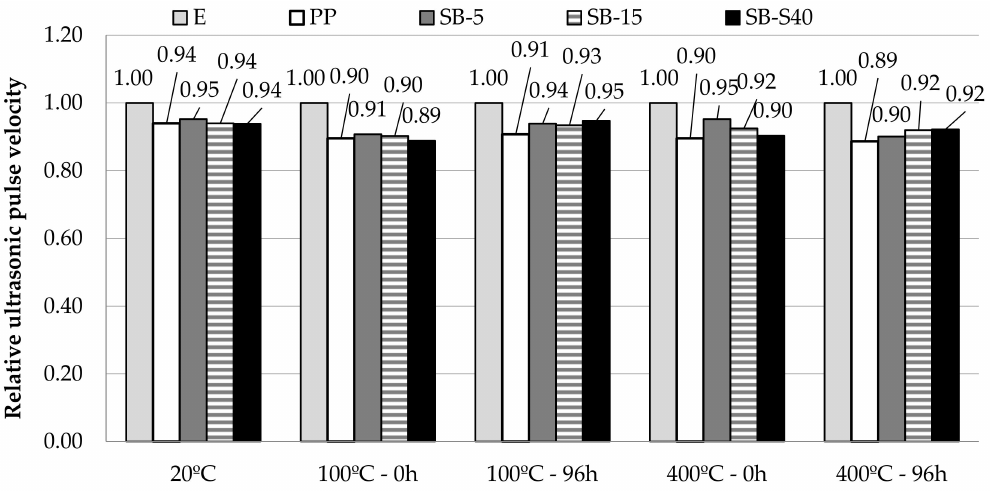
Figure 9. Residual ultrasonic pulse velocity of reinforced concretes compared with reference mixture E under the same testing conditions.